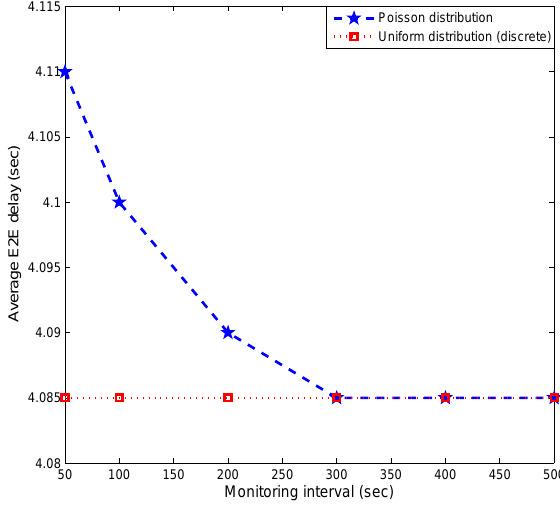
Figure 11. Impact of monitoring